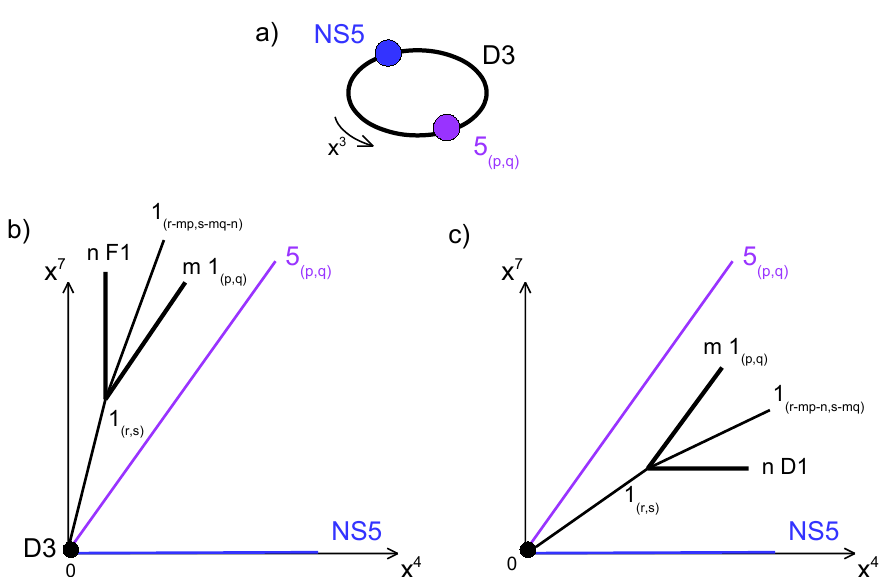
Figure 41 . (a) Brane realization of the ( p; q )-generalized abelian ABJM theory. (b) String junction for q (cid:20) s . (c) String junction for 0 (cid:20) s (cid:20) q . p r r p the presence of the 5 brane. Let us assume q > ( p;q )